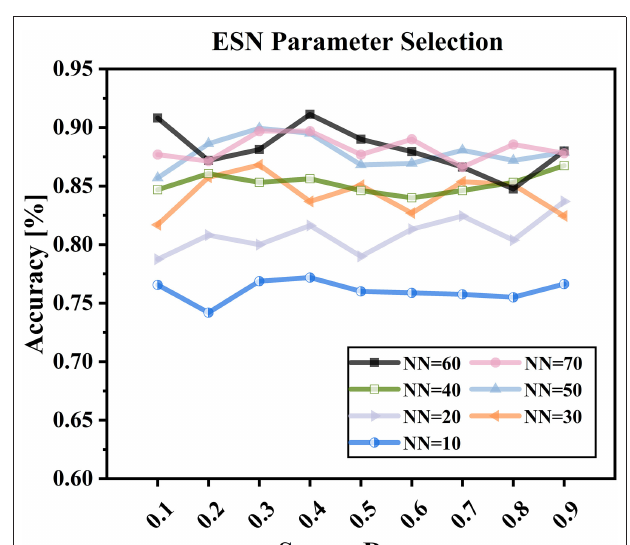
FIGURE 8 | Box-Plots of average decoding accuracy under W-OHM by using three kinds of models. The asterisk marks significant differences. Tukey-Kramer post hoc test: * p < 0.05, ** p < 0.01. comparison with the Tukey-Kramer method showed that there were significant differences between the Model 1 and Model 2 ( p = 0.02), the Model 1 and the proposed model ( p = 0.02), and the Model 2 and the proposed model ( p < 0.01), as shown in Figure 8 .